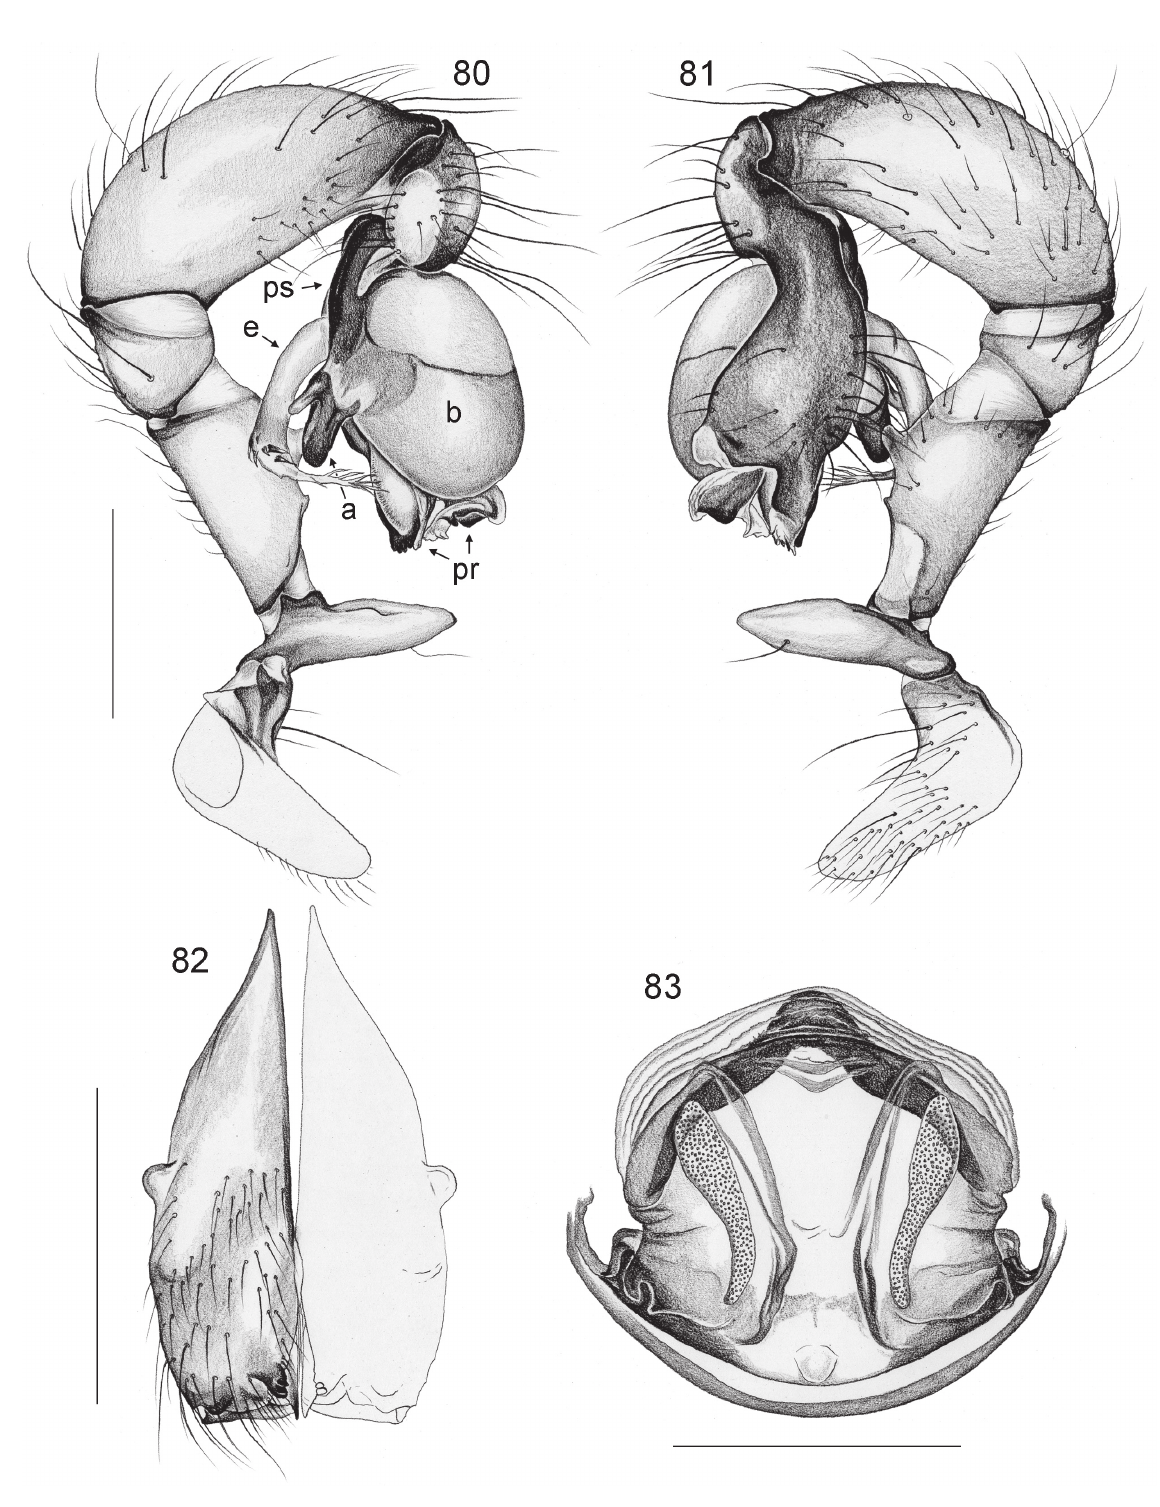
Figs 80-83. Pholcus rawiriae sp. nov. 80-81 . Left ♂ palp, prolateral and retrolateral views. 82 . ♂ chelicerae, frontal view. 83 . Cleared ♀ genitalia, dorsal view. a = appendix; b = bulb; e = embolus; pr = procursus; ps = proximal sclerite of bulb. Scale lines: 0.5